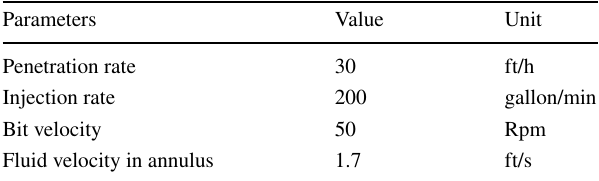
Table 4 Operating conditions used in the simulations